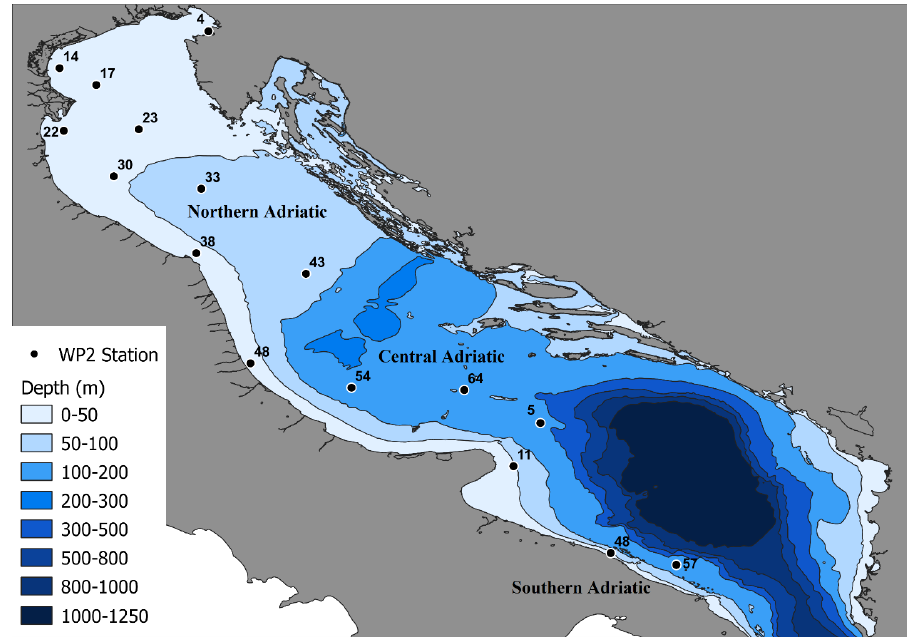
Figure 1. Map of the study area with indication of WP2 net stations (black